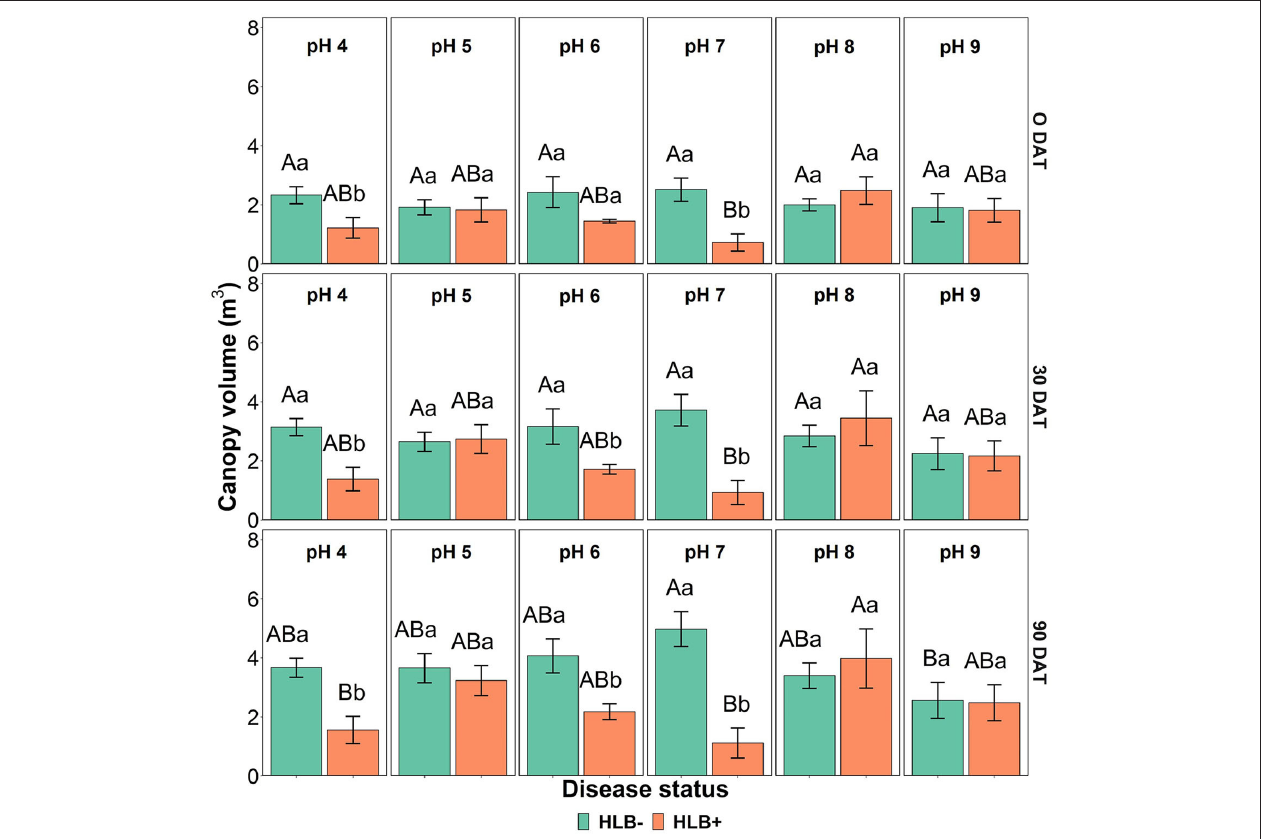
FIGURE 7 | Canopy volume interactions of “Ray Ruby” grapefruit ( C, paradisi ) on sour orange ( C. aurantium ) rootstock exposed to different HLB disease statuses [HLB-free or healthy (negative, HLB–) and HLB-affected (positive, HLB + )] under an increasing range of substrate pHs (4–9) at 0, 30, and 90 DAT. Means ± standard error ( n = 4) followed by the same letters are not different by Tukey honest significant difference (HSD, α = 0.05). Means with the same uppercase letters are not different on each substrate pH within disease status and means with the same lowercase letters are not different within the disease status per substrate